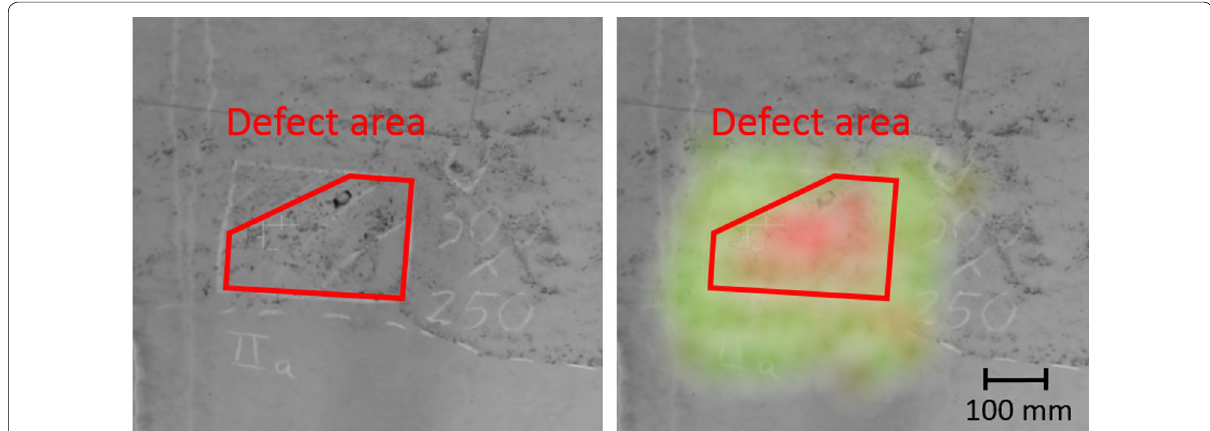
Fig. 14 Results of our proposed method on the field: the red frame is the area judged defective by a professional before the experiments and on the right picture our proposed method’s results are shown using a color scale, red for spots distant from the regular model and green for spots close to the regular